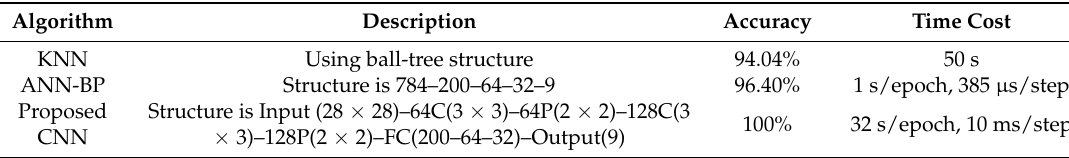
Table 9. The different algorithm